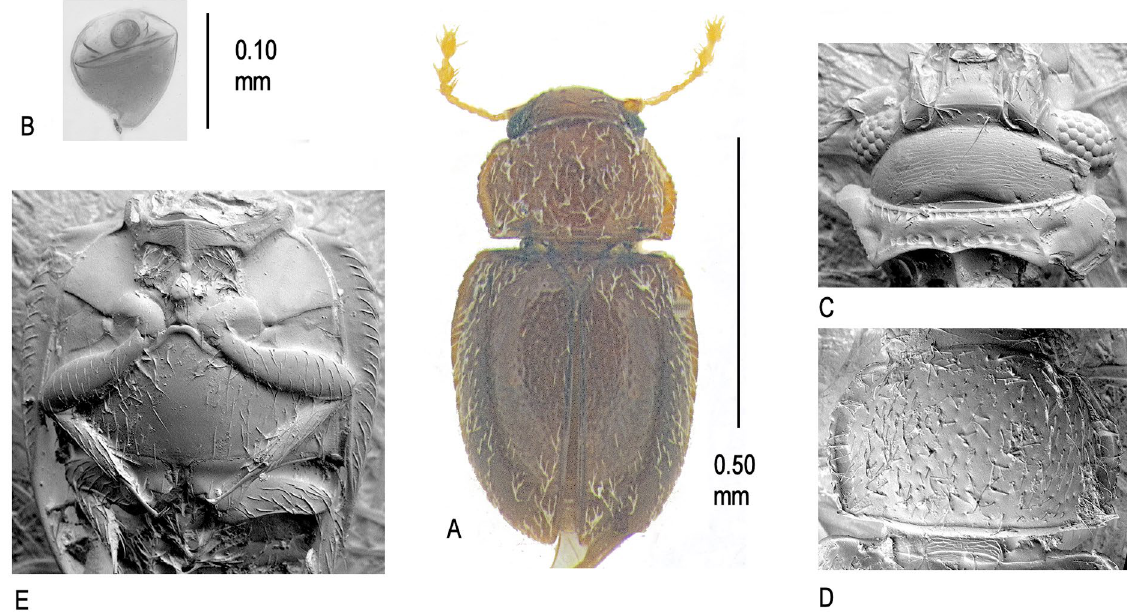
Fig. 2. Sindosium collinsi sp. nov. A . Habitus. B . Spermatheca. C . Ventral aspect of head and pronotum ×630. D . Pronotum ×510. E . Meso- and metaventra